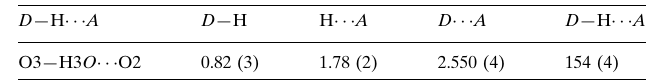
Rigaku R-Axis Spider diffractometer Absorption correction: empirical (using intensity measurements)